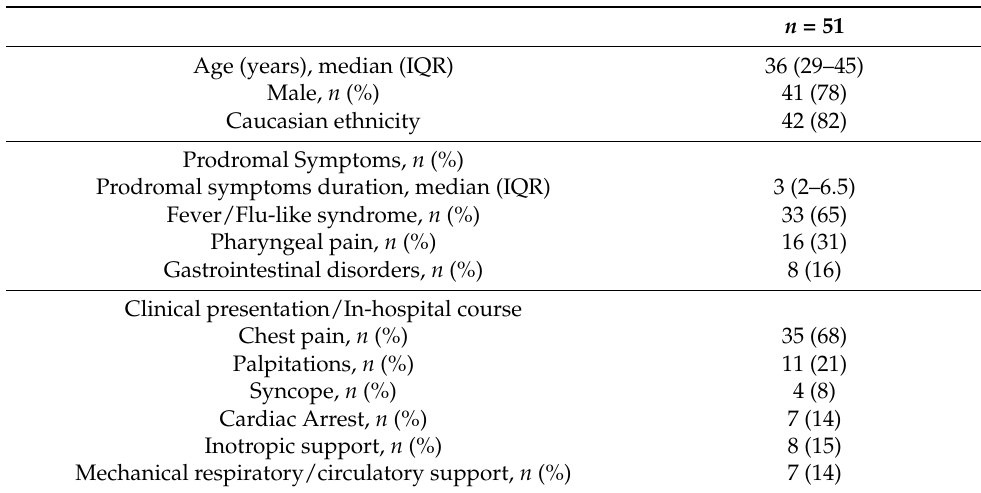
Table 1. General demographics and clinical and diagnostic characteristics of the population at presentation at the emergency department. IQR: interquartile range.